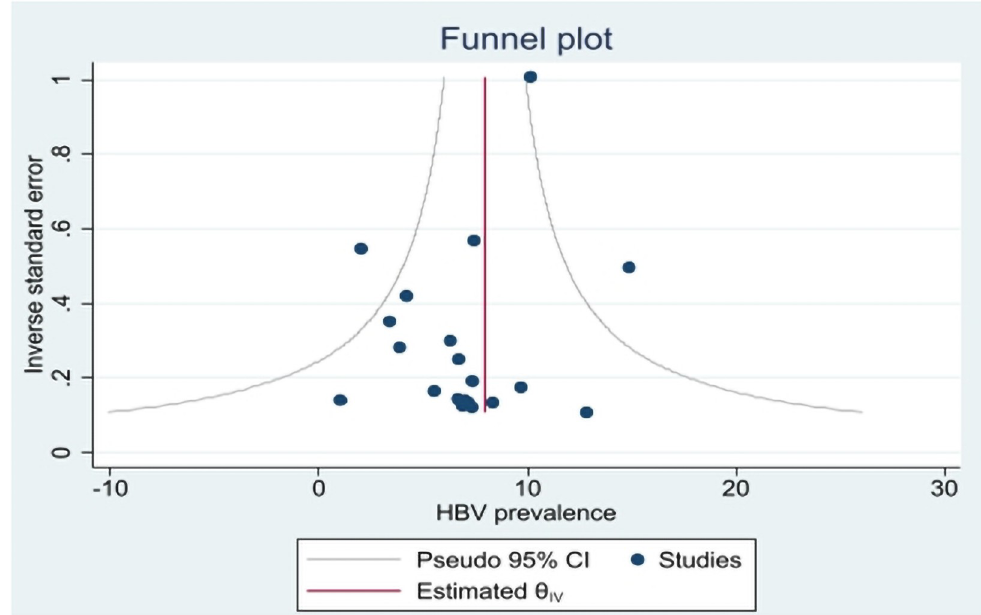
Fig 4. Funnel plot of included